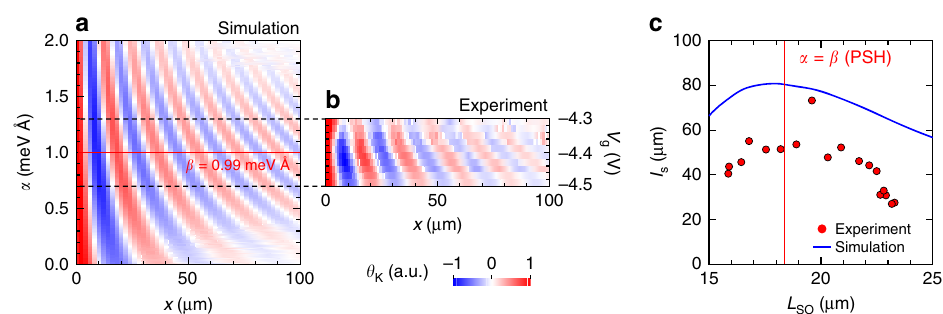
Figure 3 | SOI dependence of spin dynamics of drifting spins. ( a ) Comparison of simulated and experimental spin distribution driven by V x ¼ 50mV in the x direction. In the simulation, we directly varied the Rashba SOI parameters a and the spin distribution is shown as a function of a , whereas ( b ) the experimental data are plotted as a function of gate voltage, which modulates the Rashba SOI. Note that the gate voltage shown in this figure does not correspond to that in other experiments because the measurements were carried out on different days leading to different offset voltages. ( c ) Spin decay length as a function of spin precession